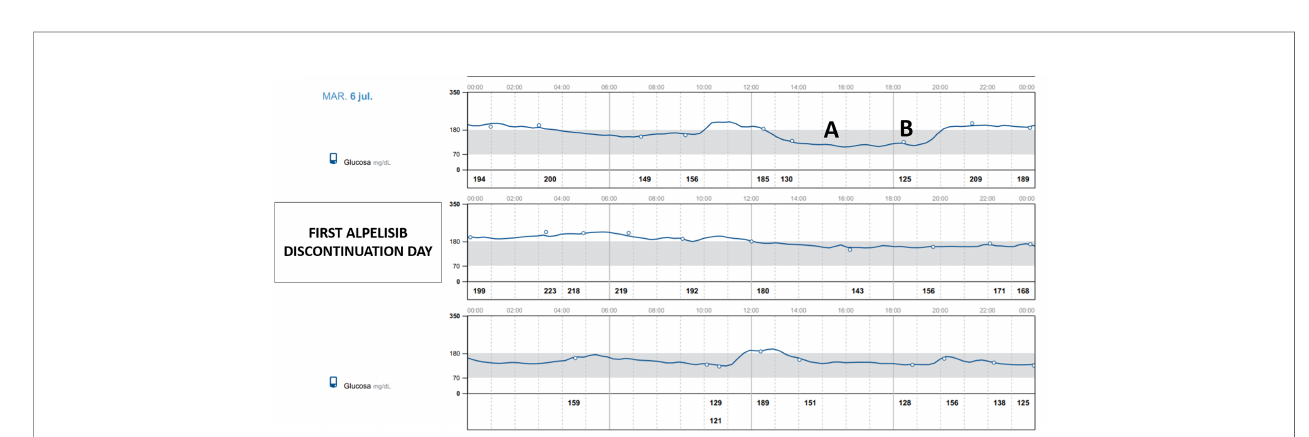
FIGURE 3 | FreeStyle Libre 2 ® Abbott Glucose Monitoring (LibreView system) following alpelisib discontinuation. (A) Last alpelisib daily dose, (B) Last insulin